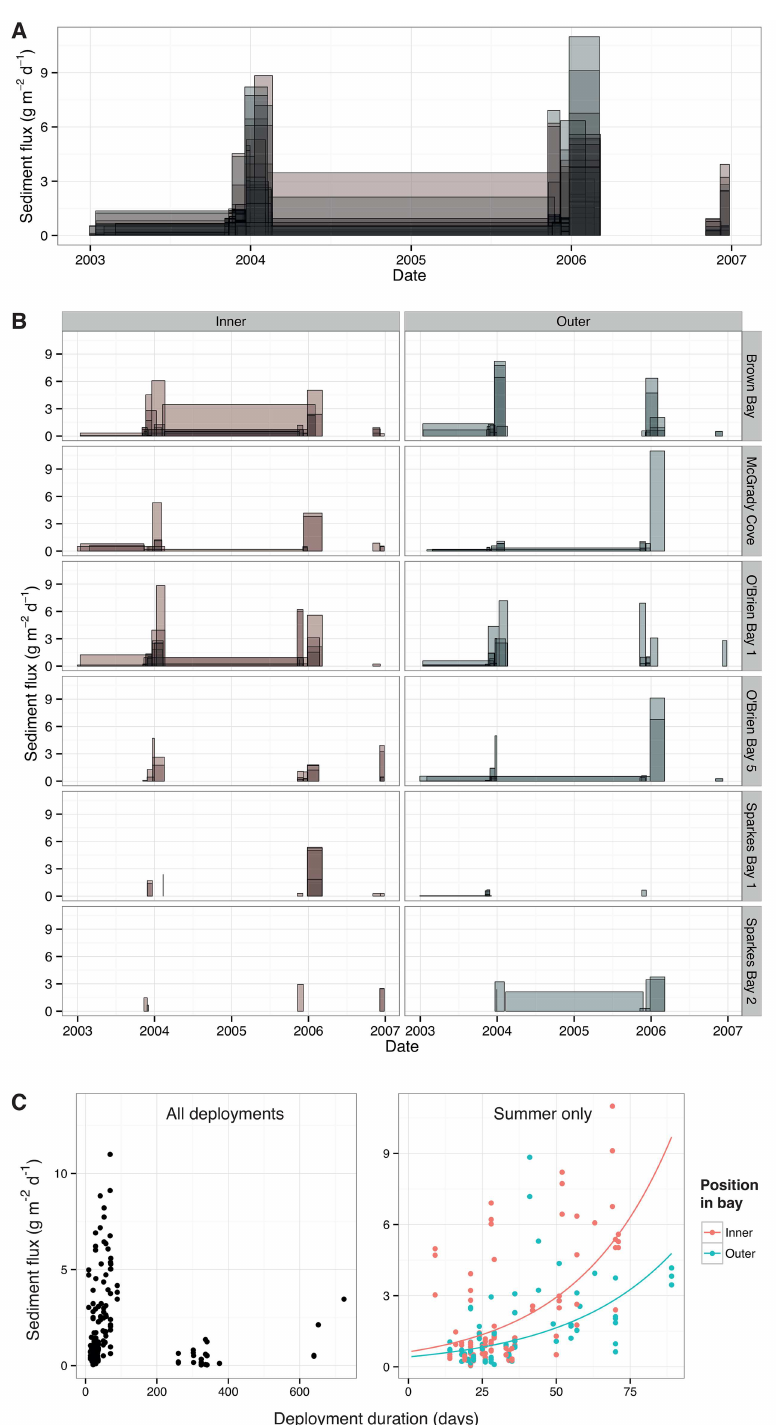
Fig 3. Sedimentation flux through time. (A) Polygonsare individual sedimenttraps, with height showing averagedaily sedimentflux and width showingdeployment duration. Colour representsposition in bay: red = inner, green = outer. (B) As above, but data are partitionedinto sites and positionwithin bay. (C) Plots of averagedaily sedimentflux vs. deployment duration. Left-handplot shows all traps, and right-handplot shows traps deployedduringsummer only. In right-handplot, fitted lines are predictedvalues of GLMM for each positionin